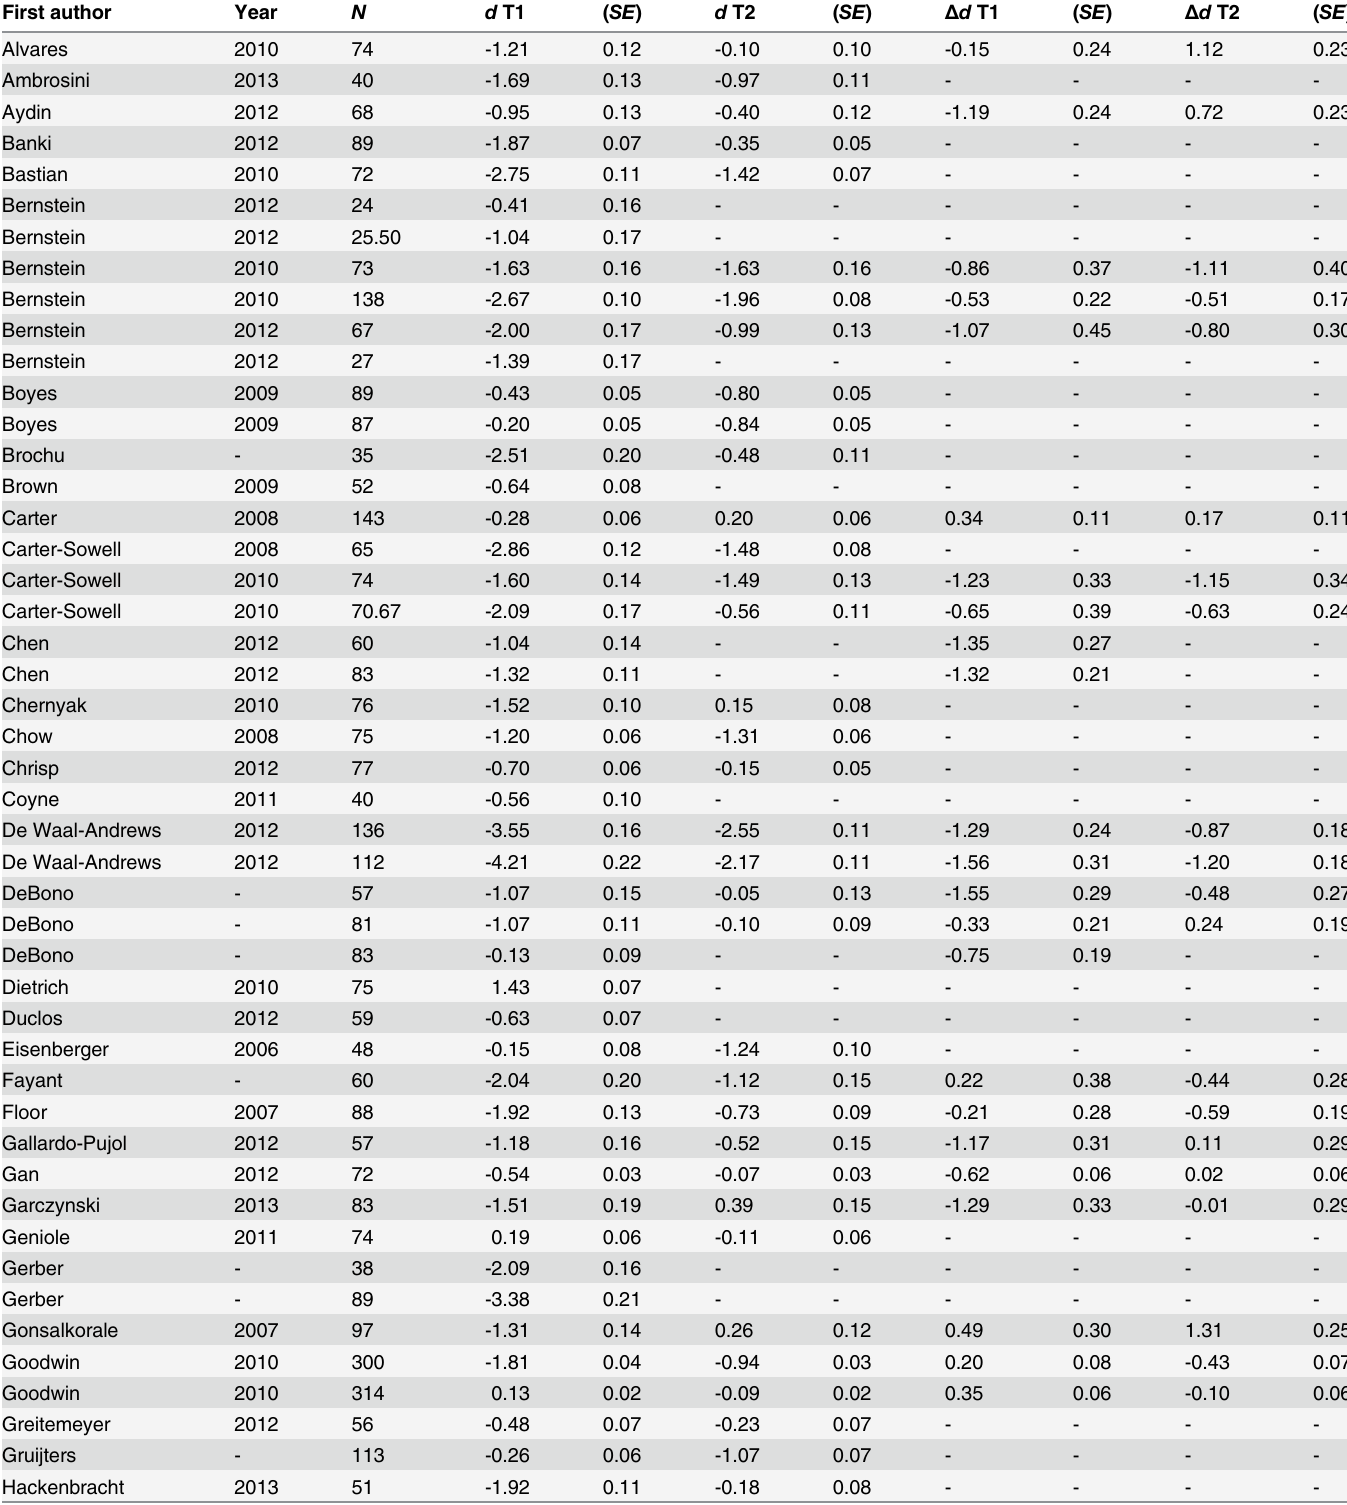
Table 2. Effect sizes per study for the primary